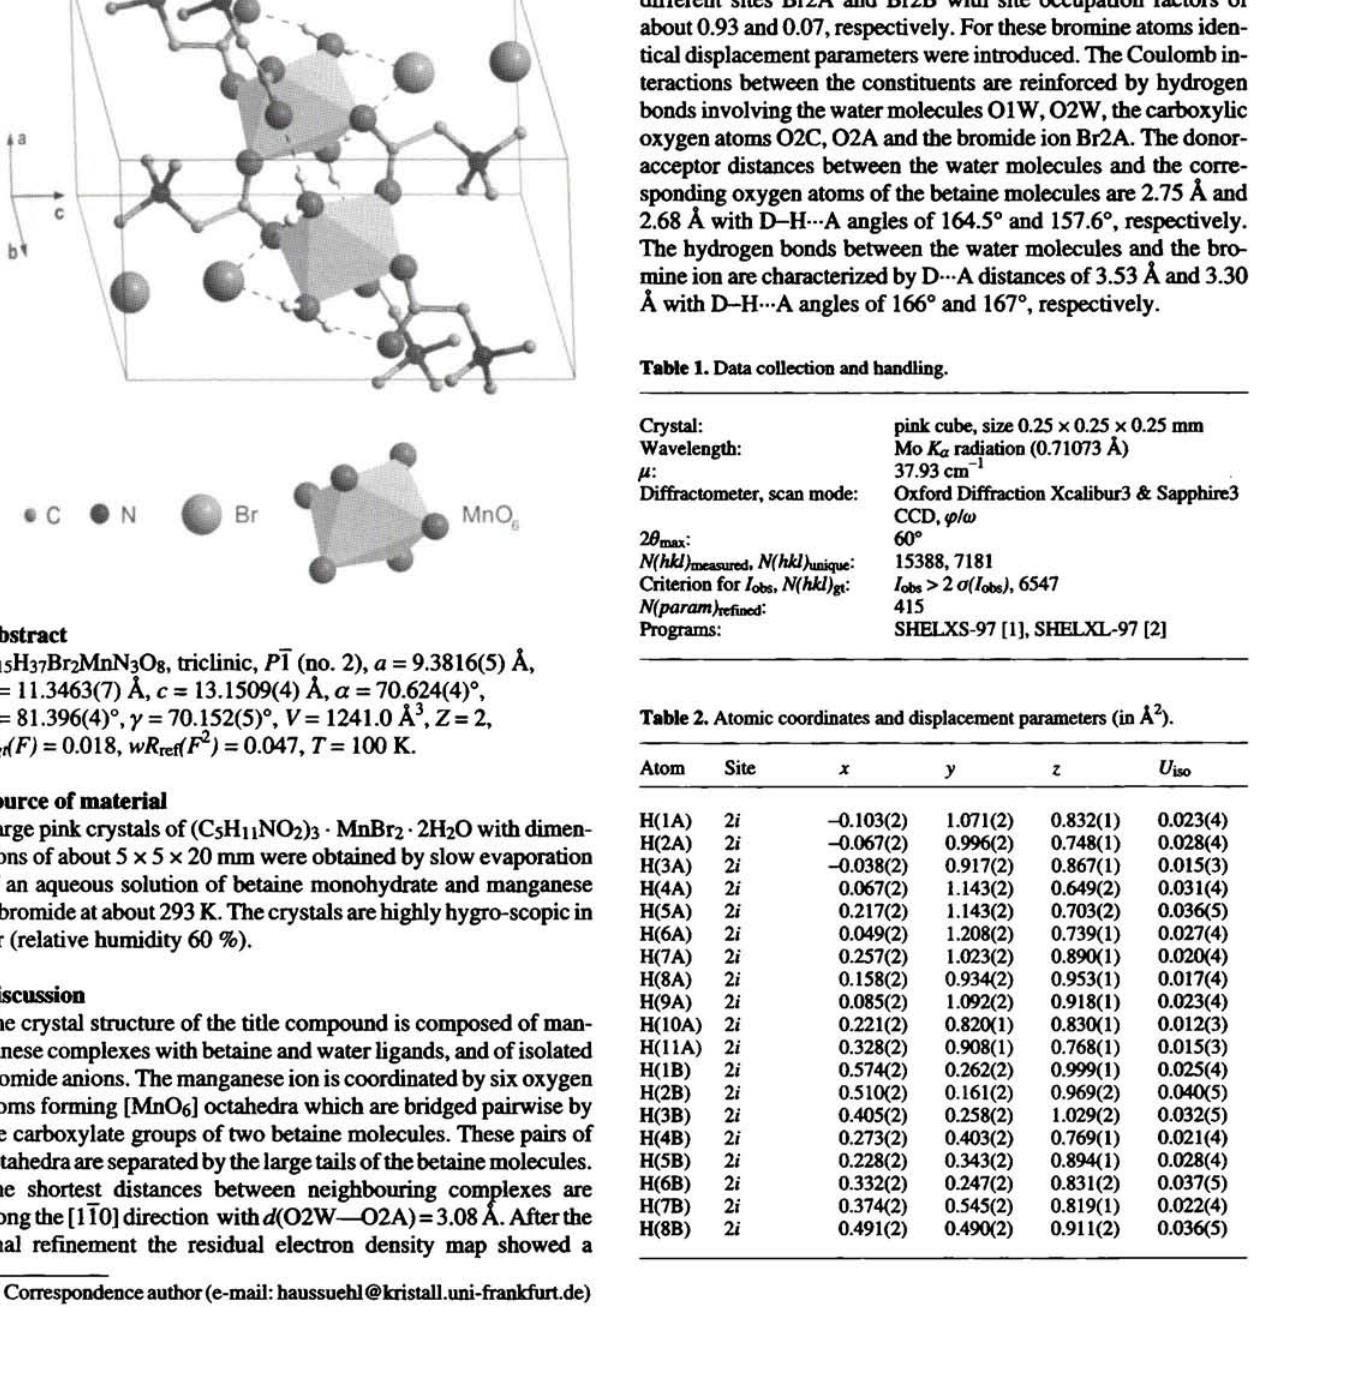
Table 2. Atomic coordinates and displacement parameters (in Â 2